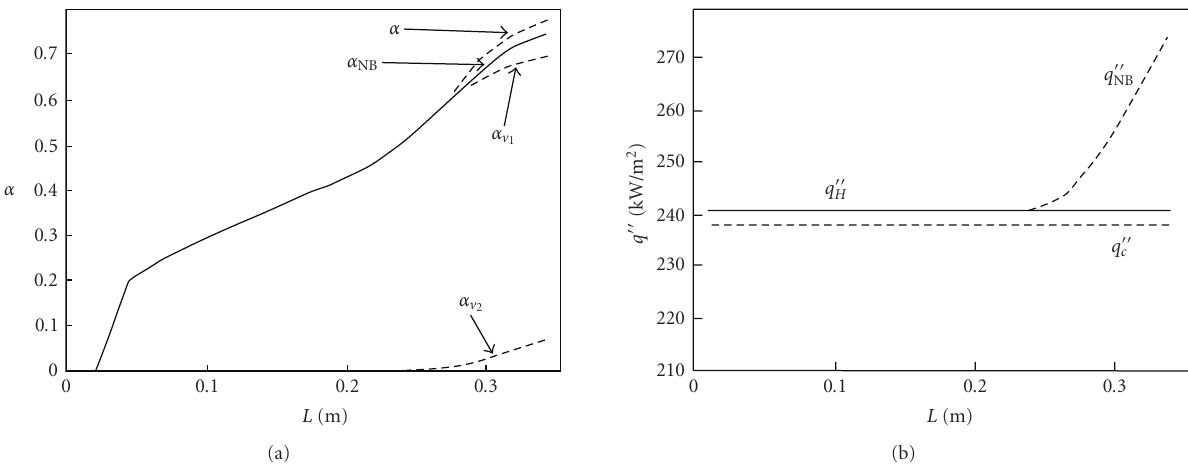
Figure 6: Axial distributions of near-wall channel parameters for the conditions shown in Figure 5: (a) the concentrations of small bubbles and elongated bubbles, (b) a comparison between the heat transfer removal rate in the elongated bubble region, average wall heat flux, and critical heat